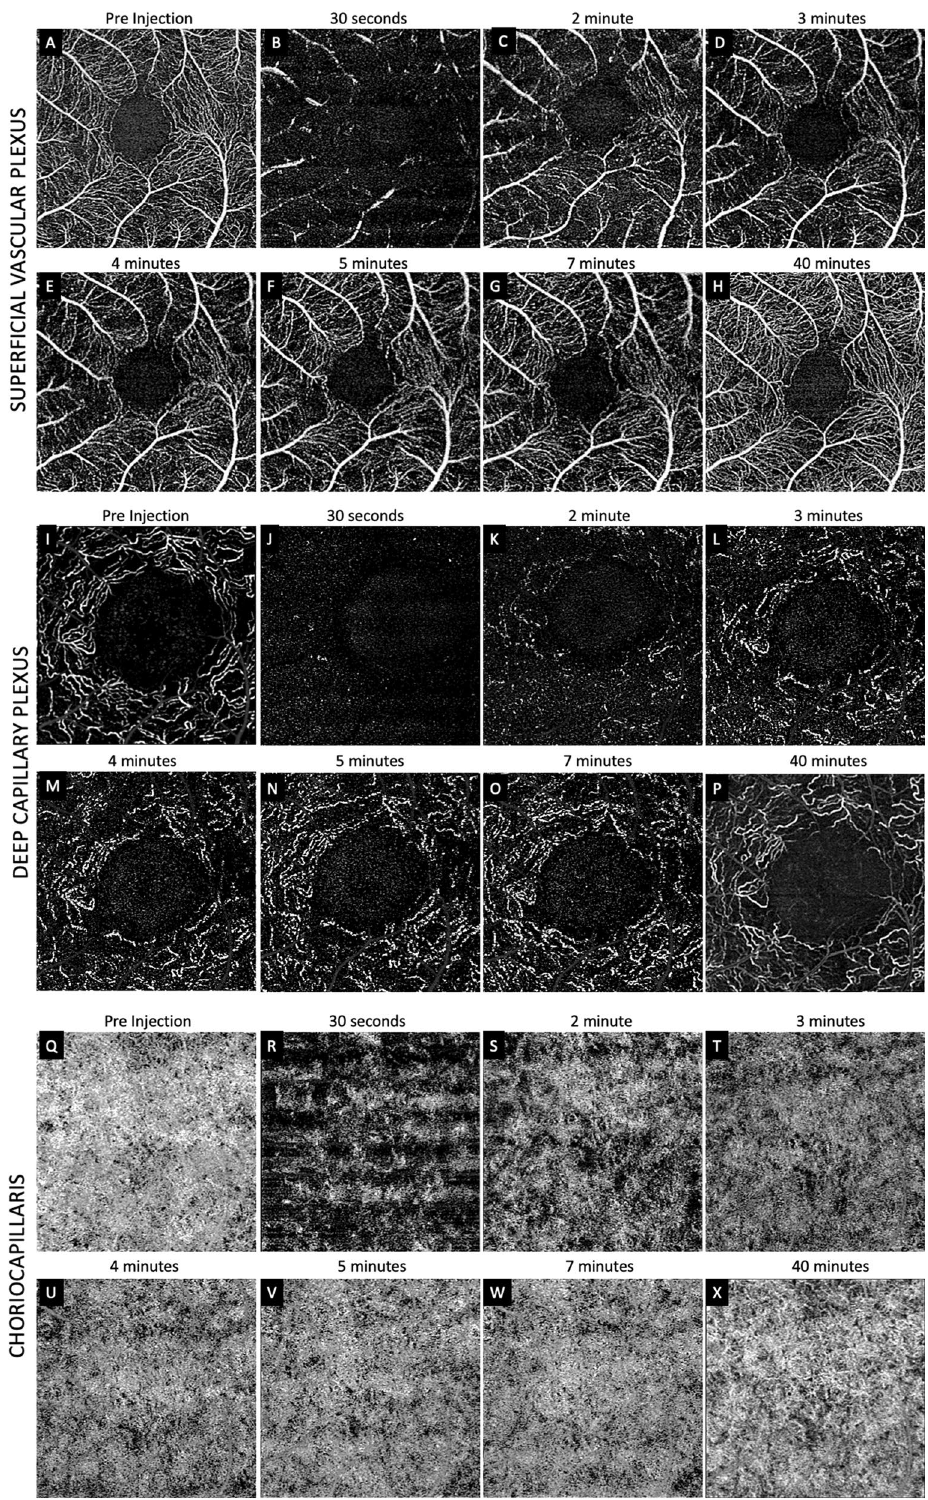
Figure 4. Sequential optical coherence tomography angiography (OCTA) Monkey 2. ( A – H ) shows superficial vascular plexus (SVP), deep capillary plexus (DCP) and choriocapillaris (CC) layers. Panel ( A ), ( I ) and ( Q ) shows pre injections OCTA of SVP, DCP and CC respectively. Intra ocular pressure (IOP) was 99 mmHg at 30 s which dropped to 14 mmHg at 7 min. The progression of flow throughout the layers were similar to Monkey 1, but the delay in reperfusion was more marked in Monkey 2. At 30 s, minimal to no flow was detected within the capillary beds and none in the venules in the SVP ( B ) as compared to Monkey 1 at the same time point. This difference was even more evident when comparing the DCP between animals where recognizable capillary units were only detected after 3–4 min post-injection ( M , N , O ). There were more evident areas of persistent flow deficits in the CC at 40-min post-injection ( X ) as compared to Monkey 1. Defects in perfusion was also most apparent in the DCP ( P ) compared to the SVP ( H ) and CC at 40